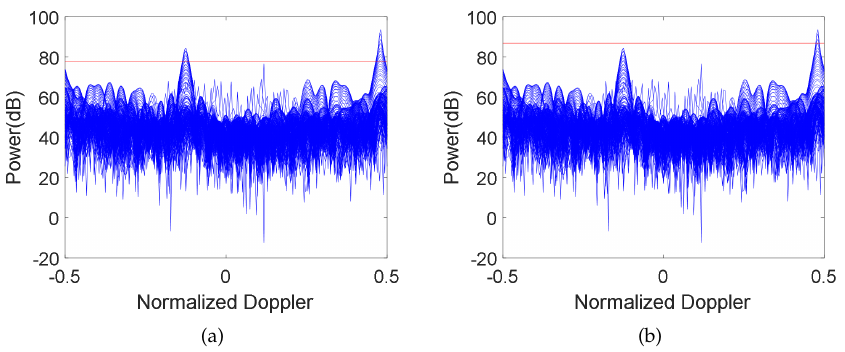
Figure 18. The results after detection, when there are two targets: ( a ) traditional method; ( b ) pro- posed method.